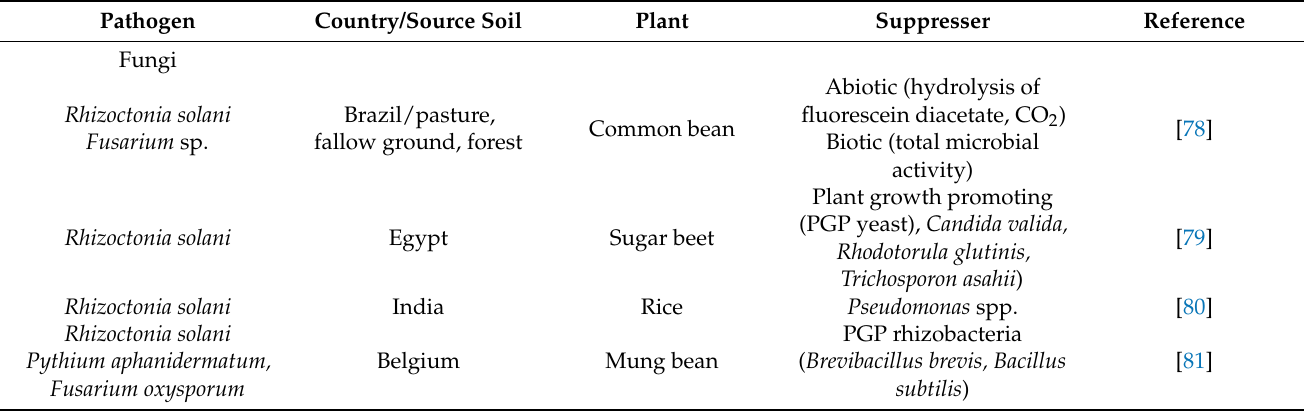
Table 2. Microorganisms and abiotic factors involved in soilborne pathogen suppression.